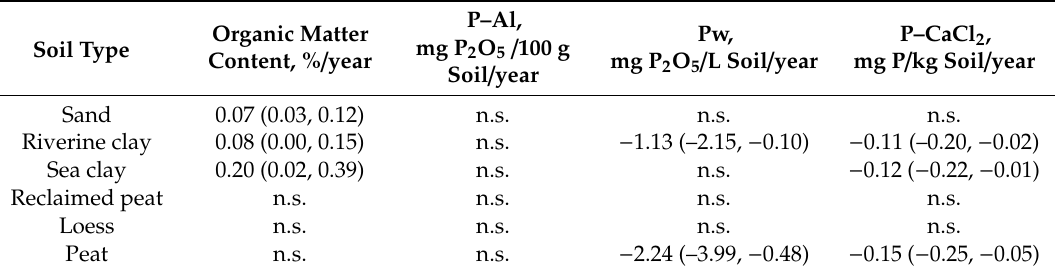
Table 3. Trends of the contents of organic matter and P status (expressed as P–Al, Pw value, and P–CaCl 2 ) in maize land on di ff erent soil types in the 2005–2015 period *